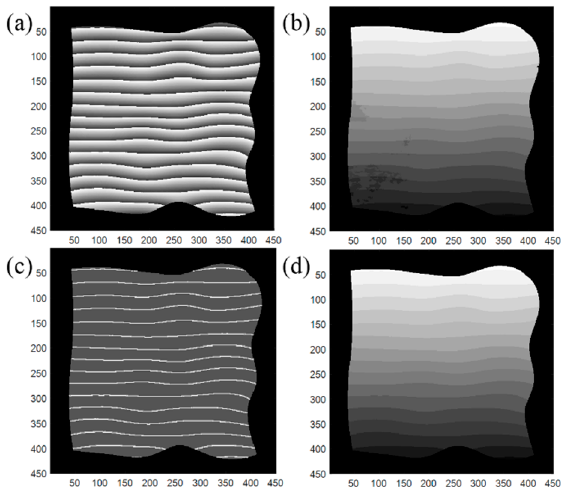
Figure 6. Simulation results on phase unwrapping. ( a ) Wrapped phase, ( b ) map of the assigned integer using the network architecture reported in [14,15], ( c ) segmented image with 4 labels from network I, ( d ) map of the assigned integer from network II.